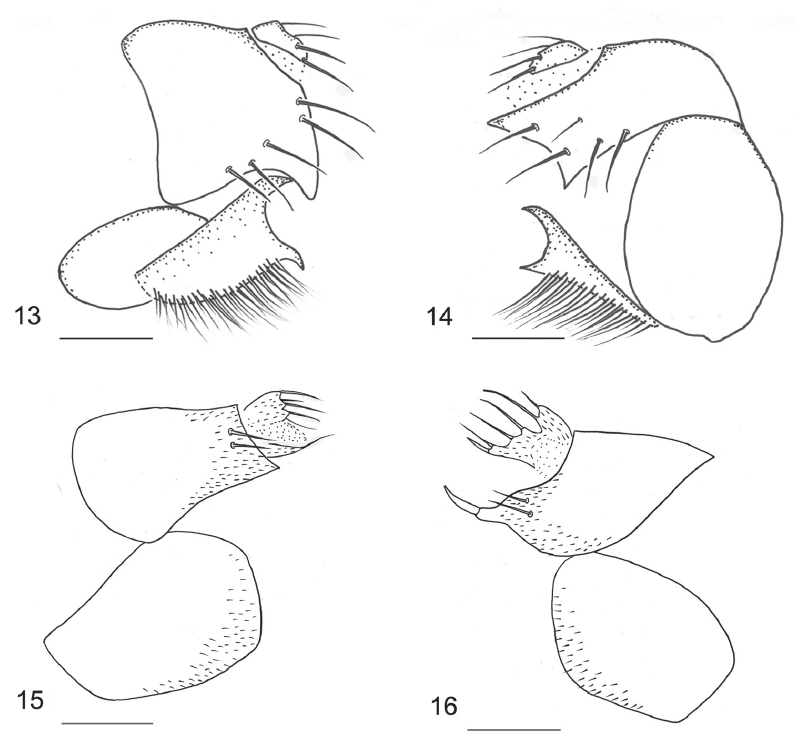
Figures 13–16. Hypopygia. 13–14 D. chaetocauda . 13 left view 14 right view 15–16 D. zaitzevi 15 left view 16 right view. Scale bars 0.05 mm.